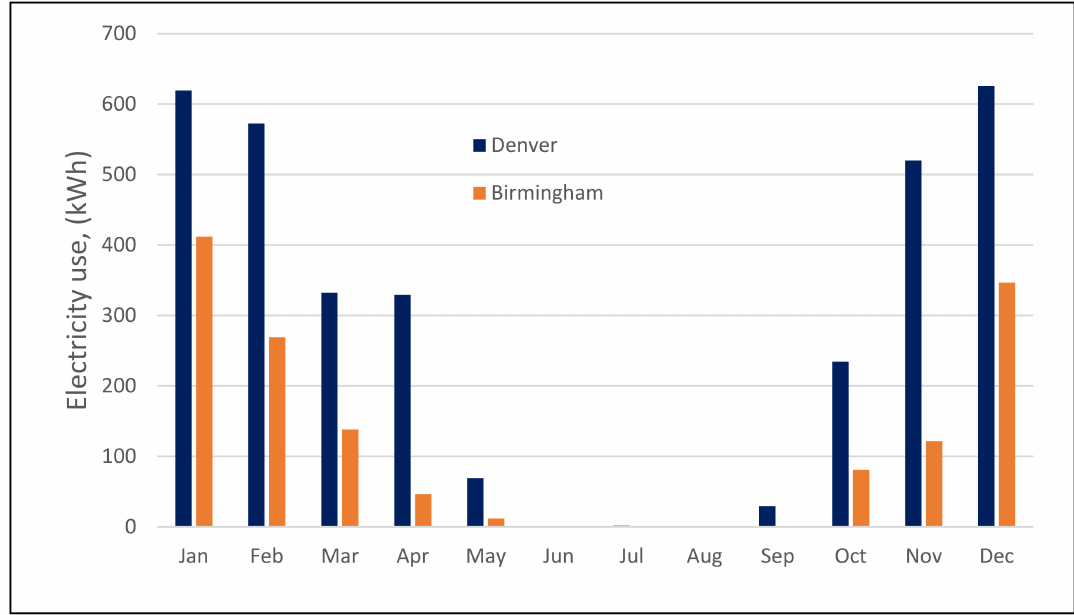
Figure 3. Annual electricity consumption for heating for the two